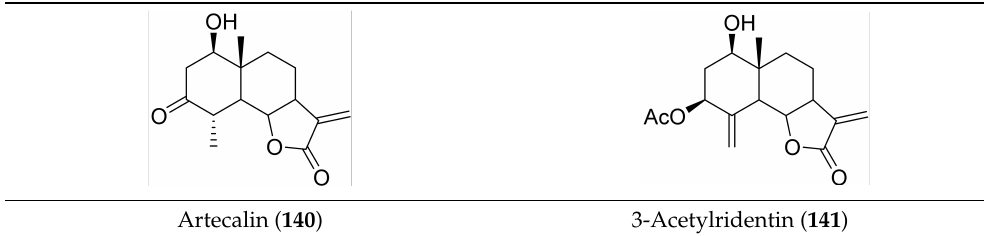
Table 13. Chemical structures of eudesmanolides from Achillea